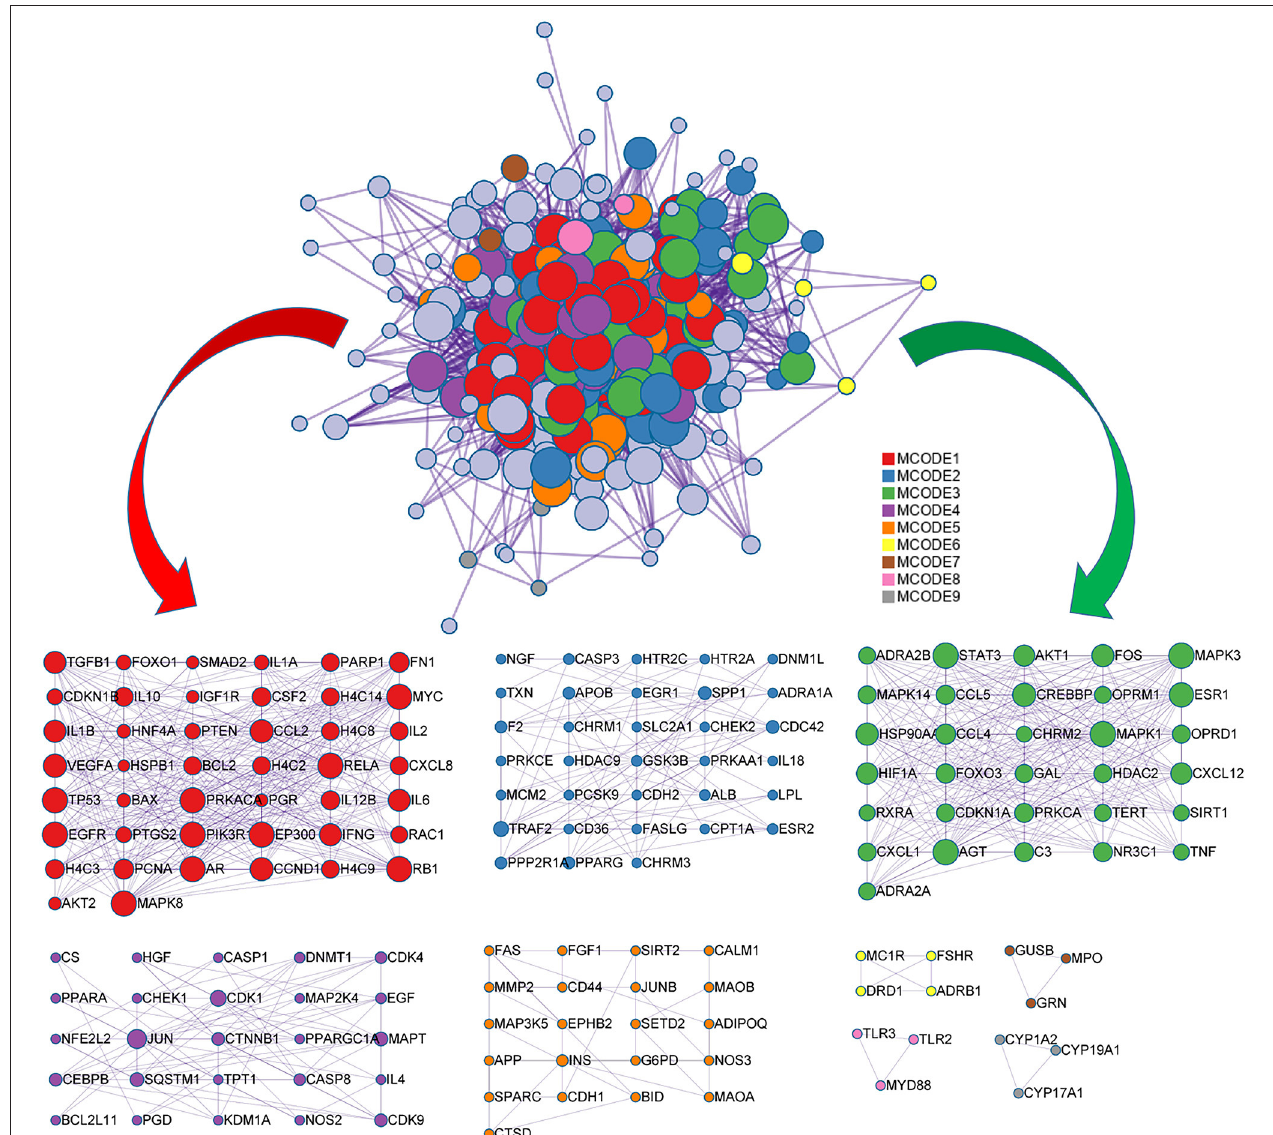
FIGURE 5 | The MCODE networks identified for